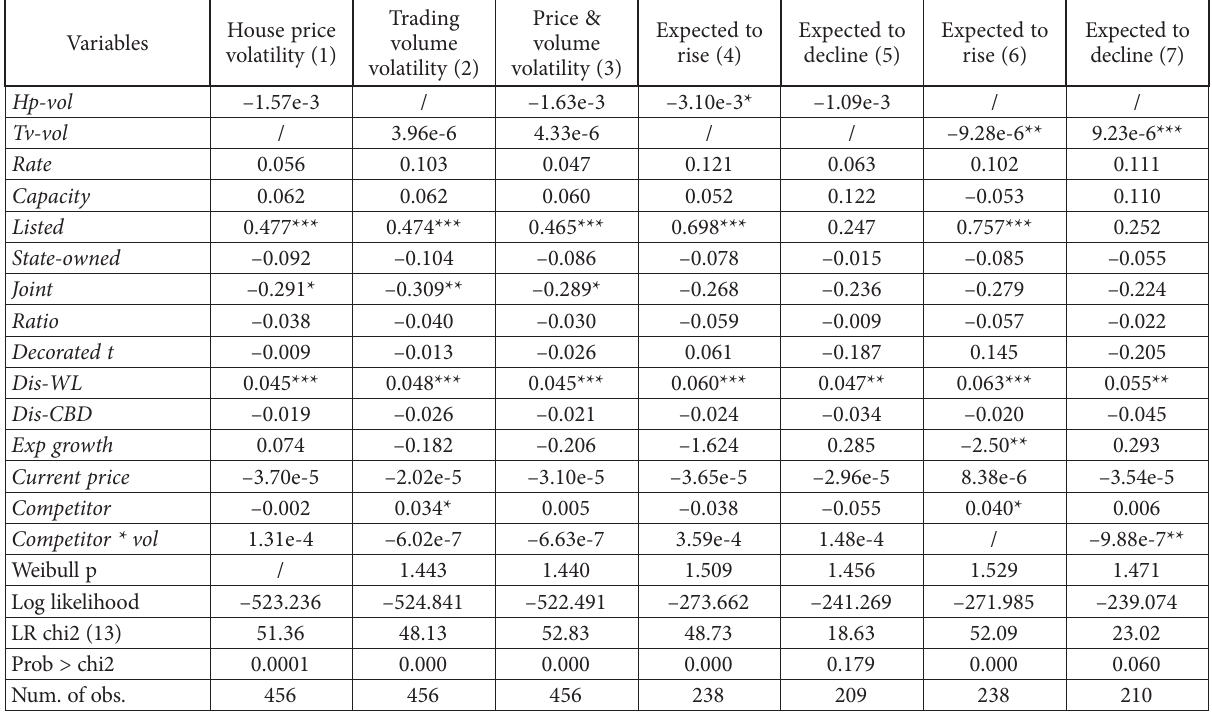
Table 2. Results of survival analysis of timing of development in main urban areas in